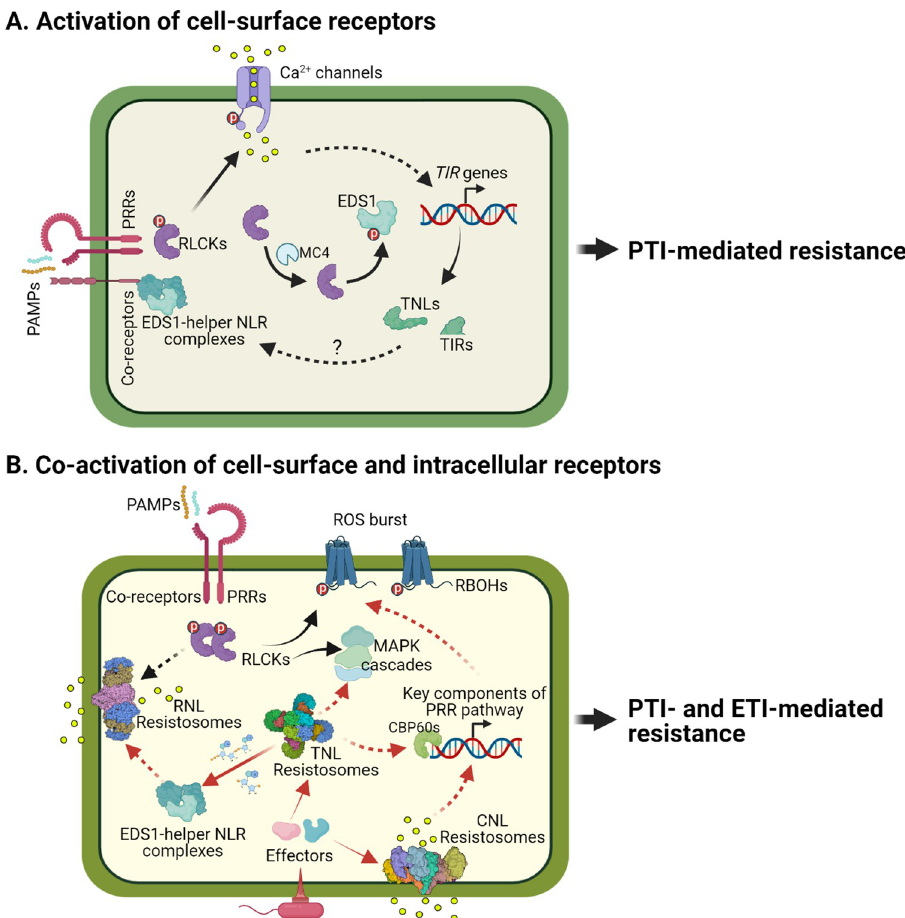
Fig 1. Schematic models for synergies between cell-surface and intracellular receptor-mediated signaling. (A) Upon ligand perception, PRRs recruit coreceptors (e.g., BAK1, CERK1) to phosphorylate each other and the downstream RLCKs. The activated RLCKs further induce Ca 2+ influx by phosphorylating Ca 2+ channels. Studies show that PTI up- regulates the transcription of TNL or TIR domain-containing genes, which requires PRR-initiated calcium flux. The cell- surface localized coreceptor SOBIR1 interacts with EDS1-helper NLR complexes to form supramolecular complexes in a ligand-independent manner, to potentially regulate PTI. Some RLCK proteins (e.g., PBL19) are cleaved by metacaspases like MC4 to generate truncated RLCKs, which phosphorylate EDS1 in the cytoplasm to boost plant resistance. (B) Activated TNL resistosomes serve as NAD + -cleaving enzymes and 2 0 ,3 0 -cAMP/cGMP synthetase. NAD + -derived small molecules are produced and activate EDS1-helper NLR complexes. CNL and helper NLR (or RNL) resistosomes form calcium-permeable channels triggering immune signaling. A recent study suggests that the formation of RNL resistosome requires both PRR and TNL signaling. Similarly, activation of RBOHD-mediating ROS burst relies on both PRR and NLR signaling. Activation of MAPK cascades by TNLs requires PRR signaling. ETI increases the transcript and protein levels of many key components of PRR pathway, possibly through members of CBP60 transcription factor family. Black arrows indicate the regulation by cell-surface receptor pathway, and red arrows indicate the regulation by intracellular receptor pathway. Solid arrows indicate direct effects, and dashed ones indicate indirect effects where the mechanism is unclear. Created with BioRender.com. CNL AU : Attheendofthefigurecaption ; anabbreviationlisthasbeencompiledforthoseusedinFig 1 : Pleaseverifythatallentriesarecorrectlyabbreviated : , coiled-coil-type NLR; ETI, effector-triggered immunity; MAPK, mitogen- activated protein kinase; NLR, nucleotide-binding domain leucine-rich repeat receptor; PAMP, pathogen-associated molecular pattern; PPR, pattern recognition receptor; PTI, pattern-triggered immunity; RLCK, receptor-like cytoplasmic kinase; RNL, Resistance to powdery mildew 8-like domain (RPW8)-type NLR, ROS, reactive oxygen species; TIR, Toll/interleukin-1 receptor/Resistance protein; TNL, TIR-type